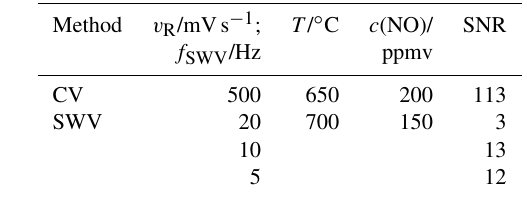
Figure 8. SWV at different frequencies ( f SWV ); (cid:49)E pulse = 0 . 1mV; (cid:49)E step = 5mV; c (NO) = 150ppmv; c (O 2 ) = 0 . 2ppmv; flow rate = 20sccm; T = 700 ◦ C. Table 1. Comparison of signal-to-noise ratios (SNRs) of CV and SWV results given in Figs. 2a and